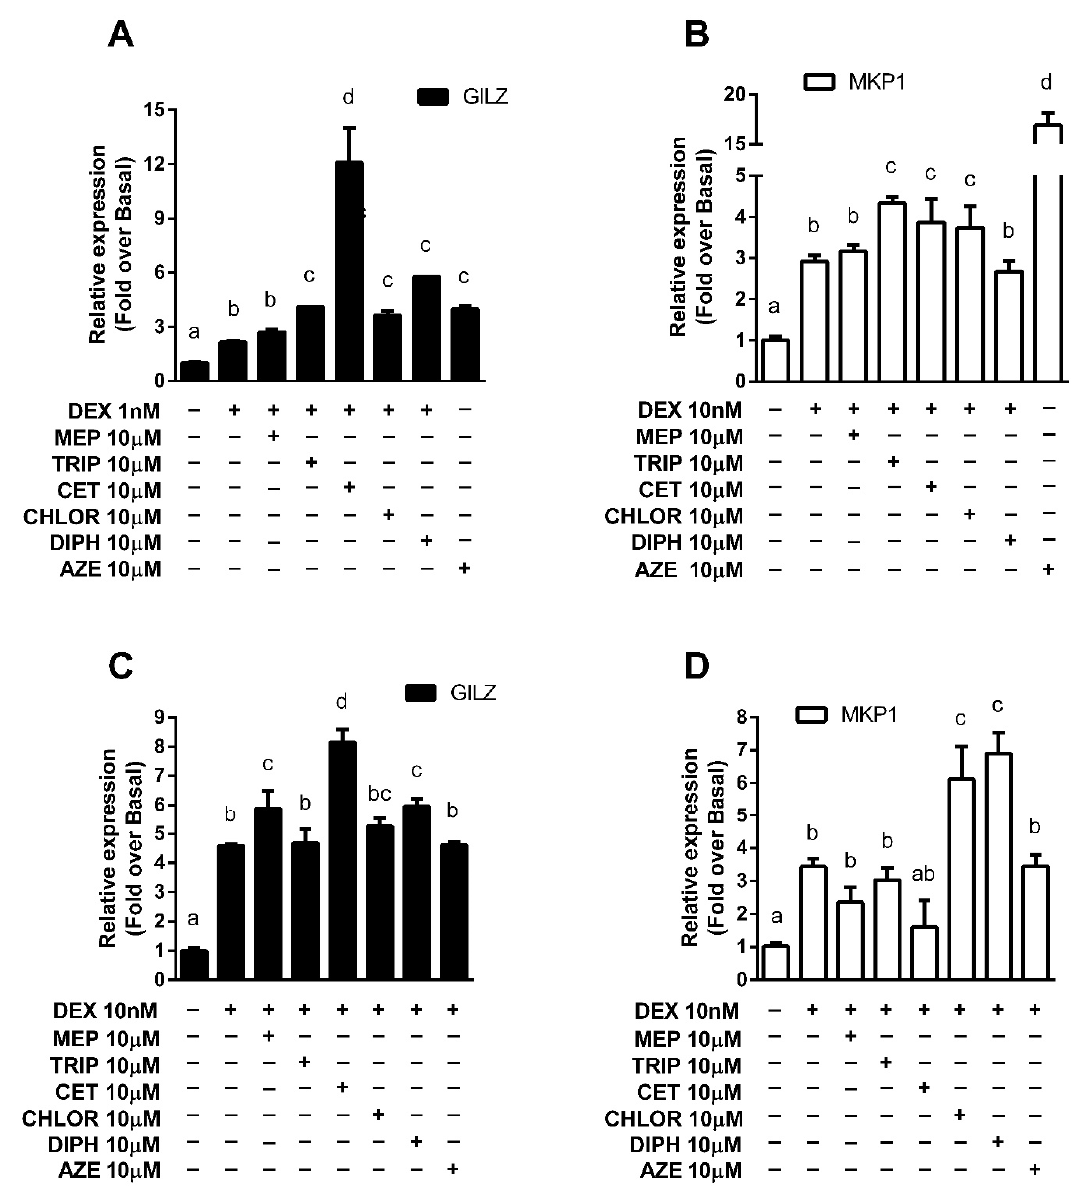
Figure 3. Antihistamines potentiate the dexamethasone-induced expression of endogenous anti-inflammatory genes. ( A , B ) A549 cells or ( C , D ) U937 cells were exposed for 10 min to 10 µ M mepyramine (MEP), 10 µ M trans-triprolidine (TRIP), 10 µ M cetirizine (CET), 10 µ M chlorpheniramine (CHLOR), 10 µ M diphenhydramine (DIPH), or 10 µ M azelastine (AZE) as indicated, and then treated with dexamethasone (DEX) for 3 h, as indicated. GILZ and MKP-1 mRNA levels were quantified by qPCR as described in the methods section. Results are mean +/ − SD of at least three independent experiments performed in triplicates. Statistical significance was denoted using letters above bars. Means indicated with a common letter are not significantly different. Likewise, means not sharing any letter are significantly different.